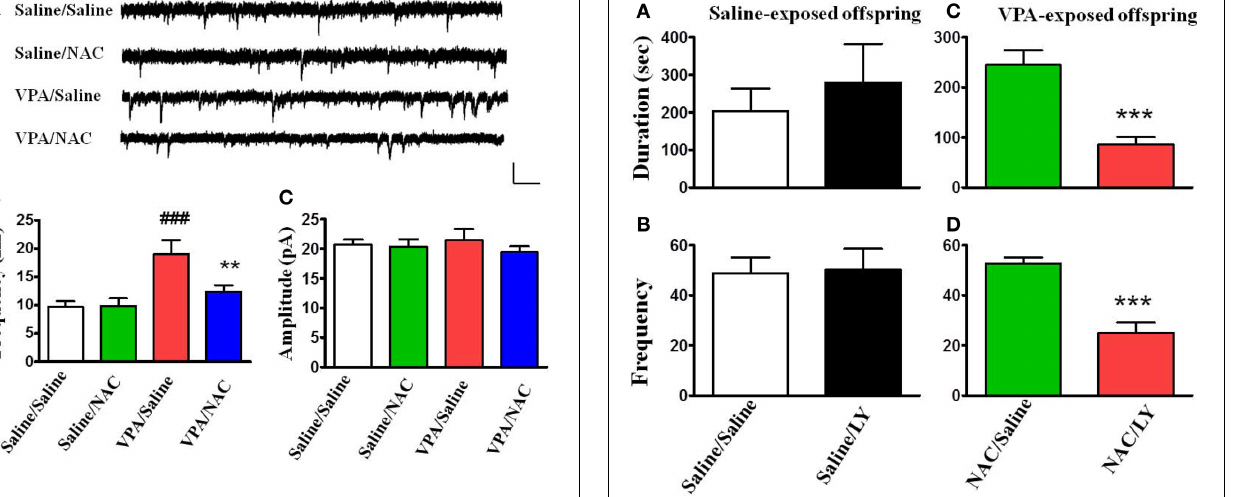
FIGURE 4 | Effects of NAC on the amplitude and frequency of mEPSCs recorded in the LA of VPA-exposed offspring. (A) Sample traces of mEPSCs taken from slices of Saline/Saline, Saline/NAC, VPA/Saline, and VPA/NAC rats. mEPSCs were recorded in the LA neurons at a holding potential of − 70mV in the presence of TTX (1 µ M). Calibration: 30 pA, 100ms. (B,C) Summary plots of the frequency (B) and amplitude (C) of mEPSCs in the Saline/Saline, Saline/NAC, VPA/Saline, and VPA/NAC rats. ∗∗ p < 0 . 01 vs. VPA/saline. ### p < 0 . 001 vs. Saline/Saline.